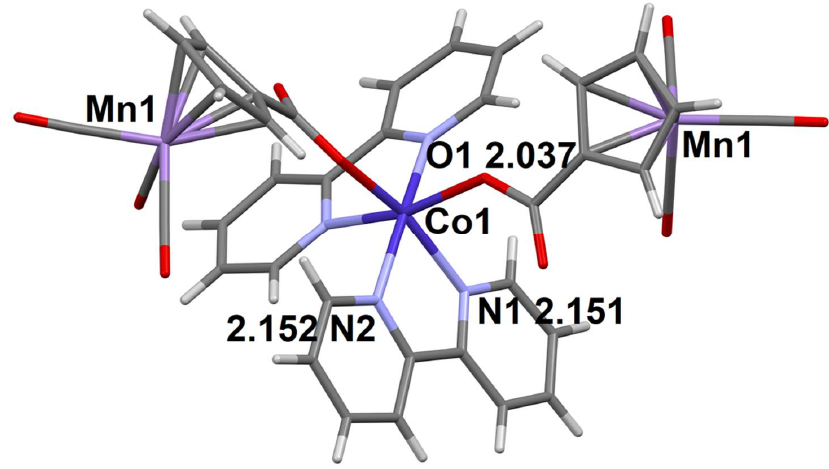
Figure 3. The structure of complex molecule in 5 . The distances between the coordinating atoms of the ligands and the Co 2+ ion are given (Å).